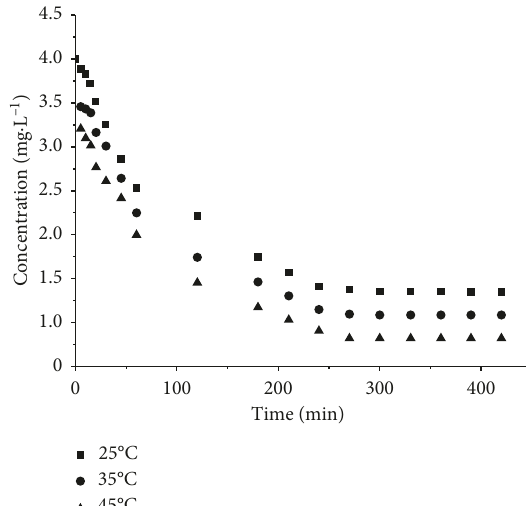
Figure 3: Concentration of fluoride ions as a function of time using epicarp as biosorbents.